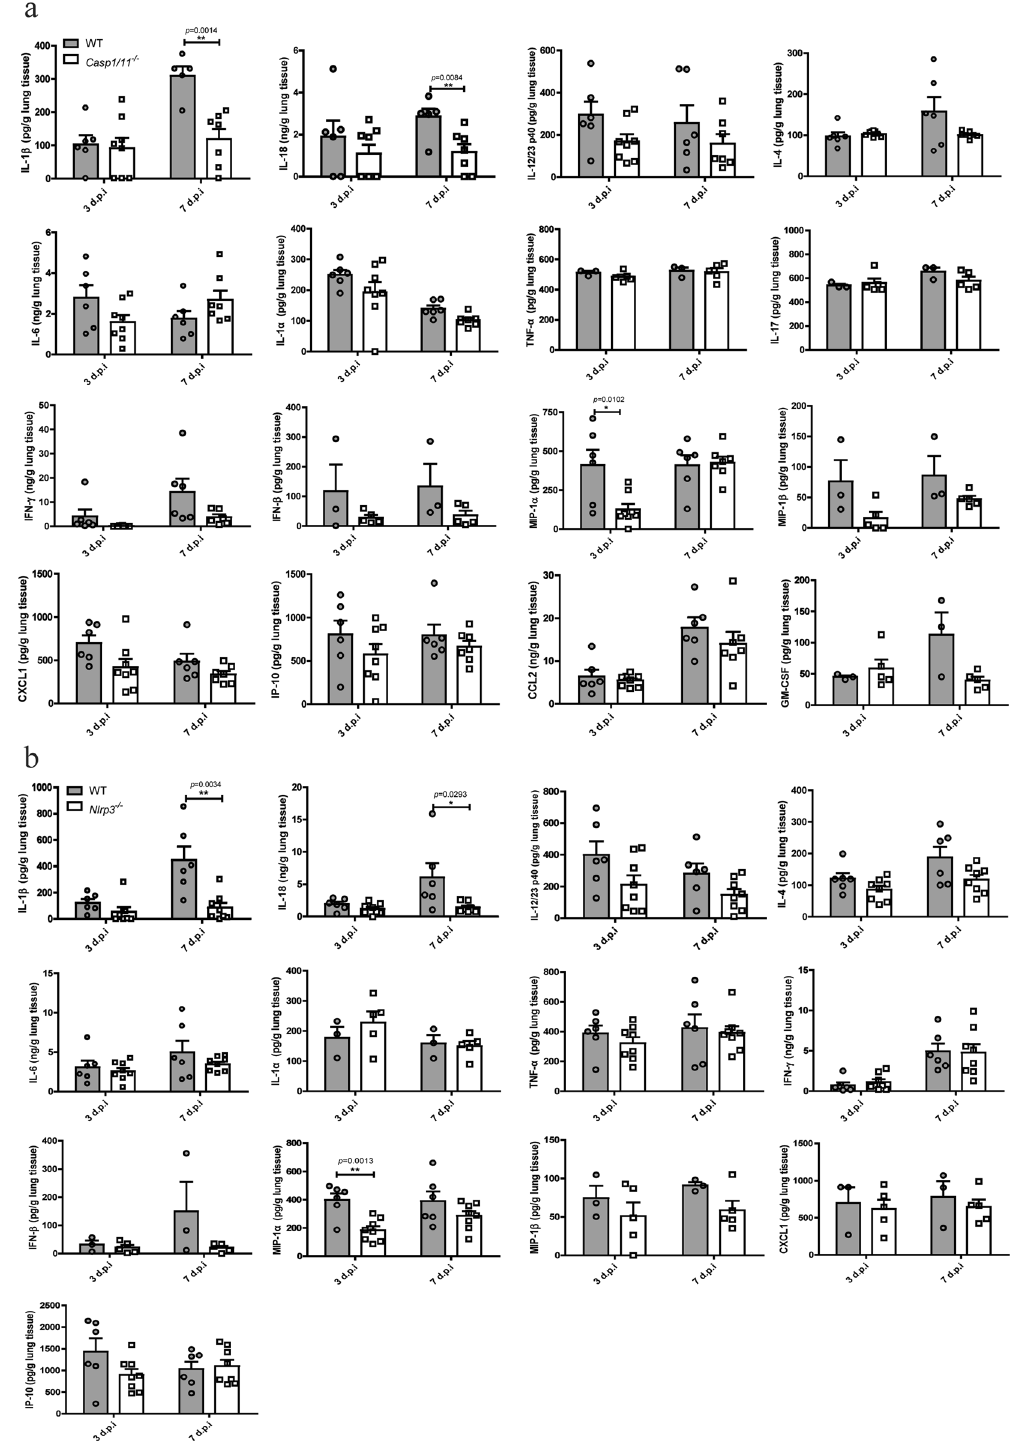
Figure 5. Deficiency of caspase-1 or NLRP3 reduces the production of proinflammatory mediators upon H7N9 infection. WT, Casp1/11 − / − ( a ) or Nlrp3 − / − ( b ) mice were infected as in Fig. 2 and the lungs were harvested on 3 or 7 d.p.i, then tissue homogenates were taken for determinations of cytokines and chemokines production as indicated. Values represent the mean of samples ± SD. Data are pooled from two independent infection experiments. ** P < 0.01, * P <